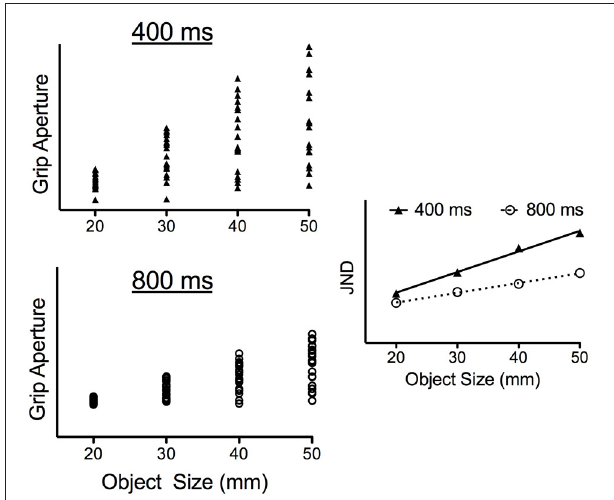
FIGURE 2 | Theoretical data demonstrating impulse-variability predictions for trial-to-trial changes in grip aperture (i.e., the JNDs) as a function of object size and grasping time condition. In particular, the left panels of this figure present grip aperture size for a theoretical participant at some early point in aperture shaping (e.g., peak aperture acceleration) across 20 trials to each of four object sizes in both the 400ms (left top panel) and 800ms (left bottom panel) conditions. For both conditions, impulse-variability predicts a stochastic increase in the range of trial-to-trial grip apertures with increasing object size (i.e., JNDs increase linearly with increasing object size). Additionally, the shortened grasping time in the 400ms condition requires larger aperture opening impulses and is therefore predicted to result in an increased range of grip apertures for each object size in comparison to matched objects in the 800ms condition. As shown in the right panel, this between-conditiondifference would render a steeper slope relating JNDs to object size in the 400ms as compared to the 800ms condition. In particular, this figure demonstrates a twofold between-conditiondifference in the JND/object size